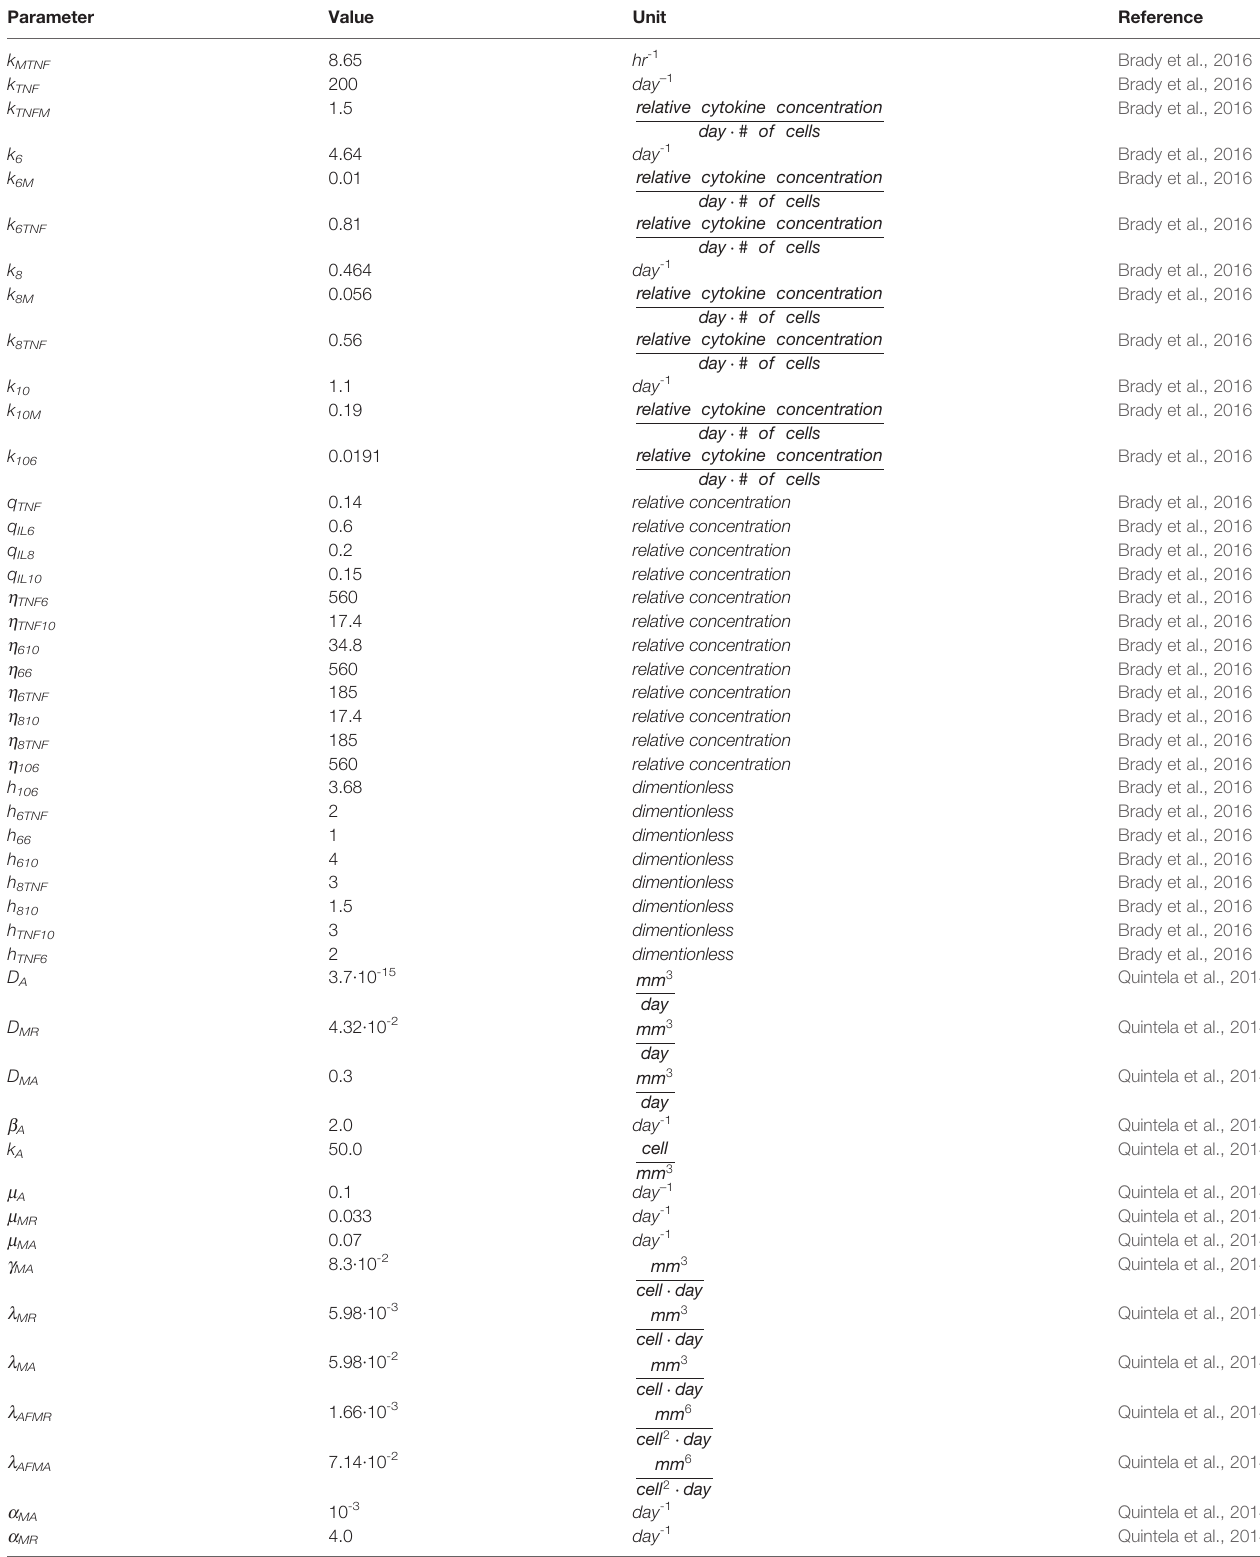
TABLE 2 | Parameters, values, and units for the variables in the partial and ordinary differential equations found in the simulation (6, 7).